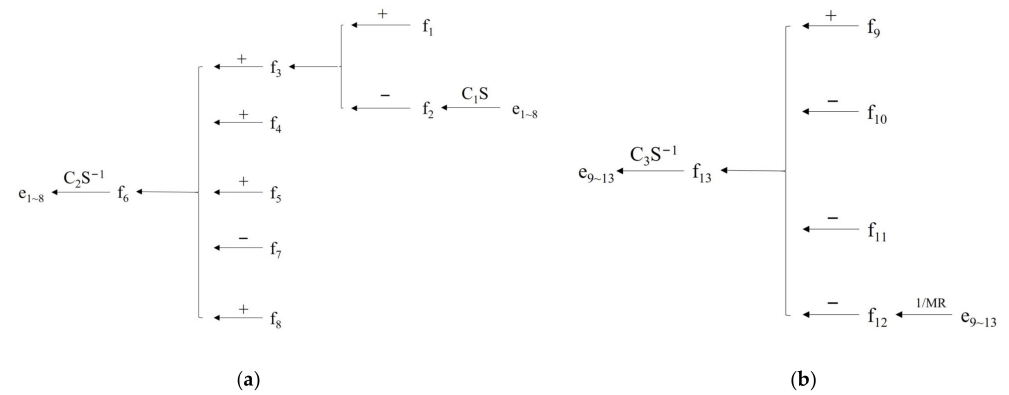
Figure 15. The variable relationship graph of the pressurizer: ( a ) for control volumes 1 and 2; ( b ) for control volume 3.